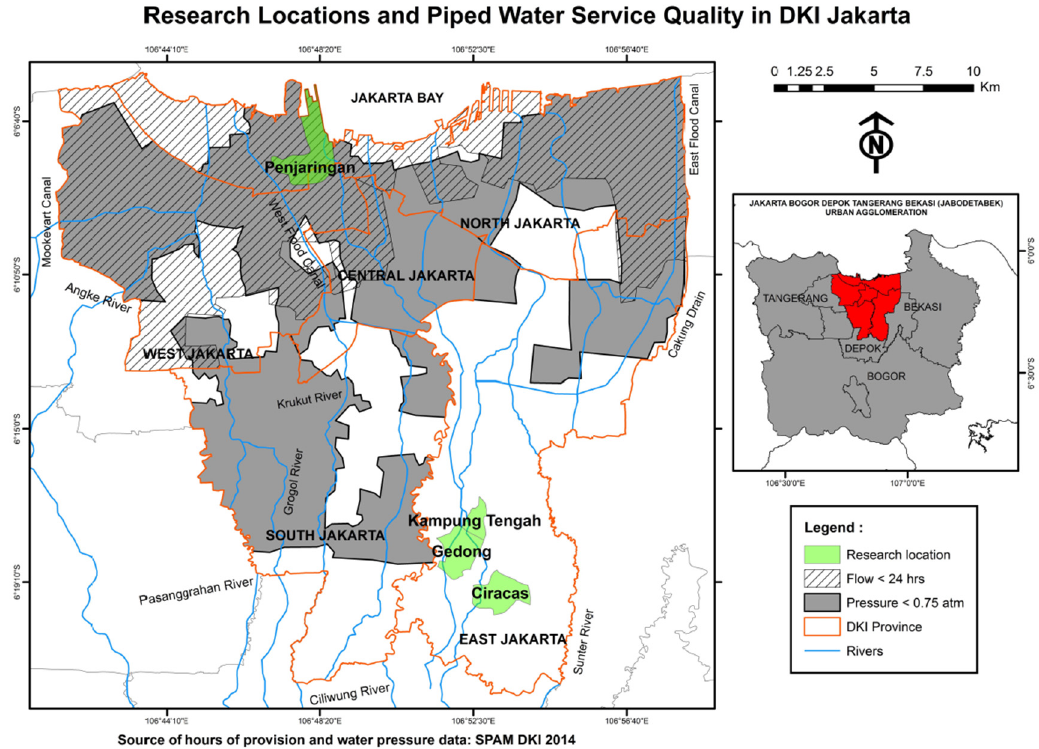
Figure 1. Research locations in North Jakarta (Penjaringan) and East Jakarta (Gedong, Kampung Tengah, Ciracas), and piped water service quality in DKI Jakarta. (Source: Authors)